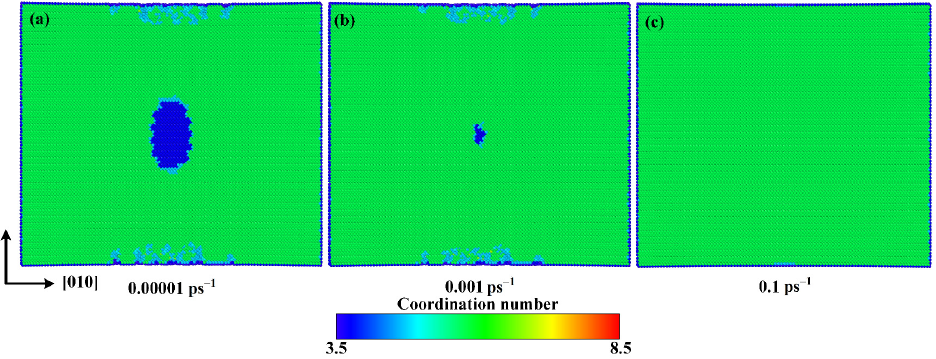
Figure 14. Atomic configurations at 0.125 strain for strain rates of ( a ) 0.00001 ps − 1 , ( b ) 0.001 ps − 1 , and ( c ) 0.1 ps − 1 .